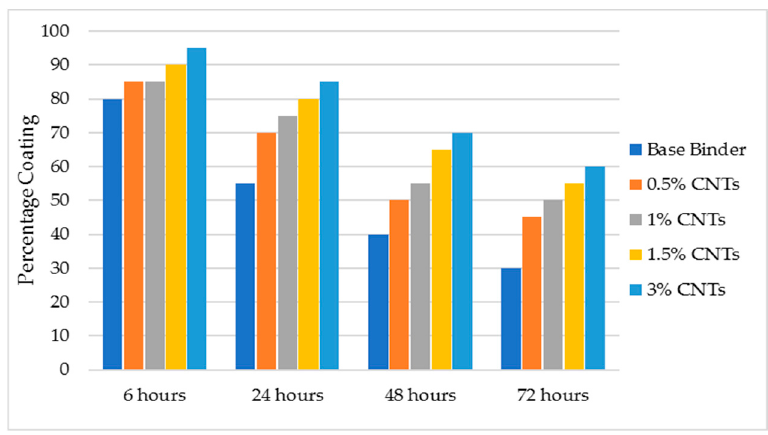
Figure 17. Loss of Coating at different durations with various CNTs percentages.